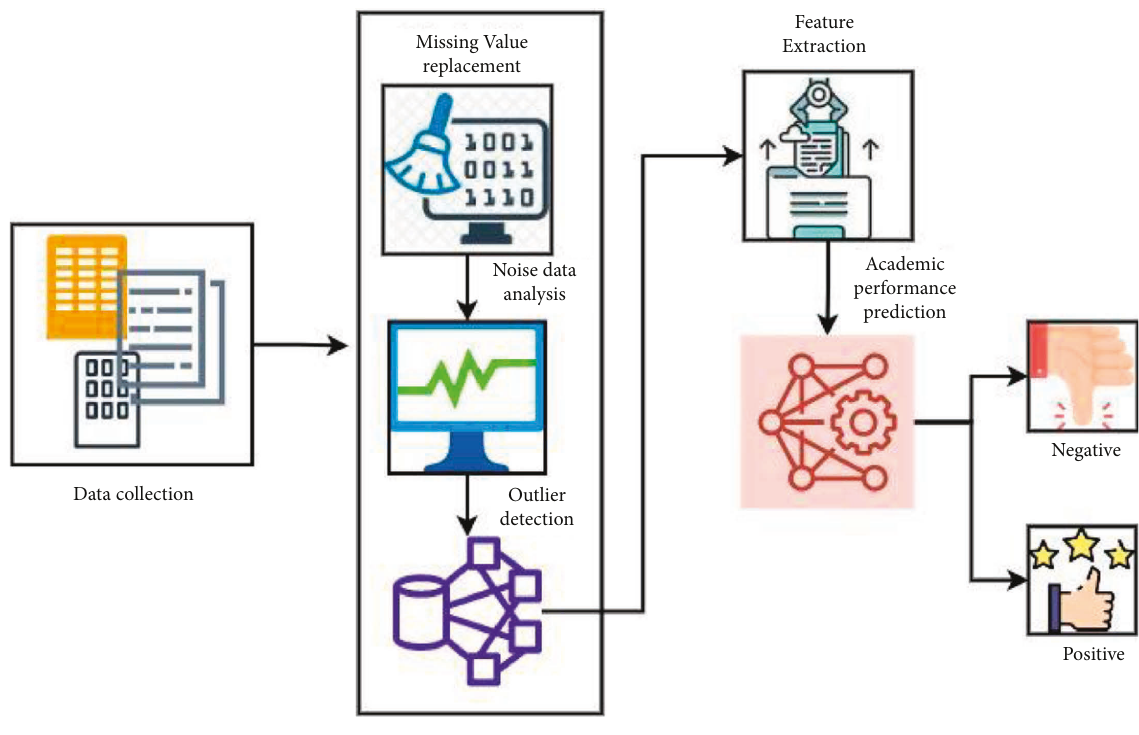
Figure 1: Student academic performance analysis